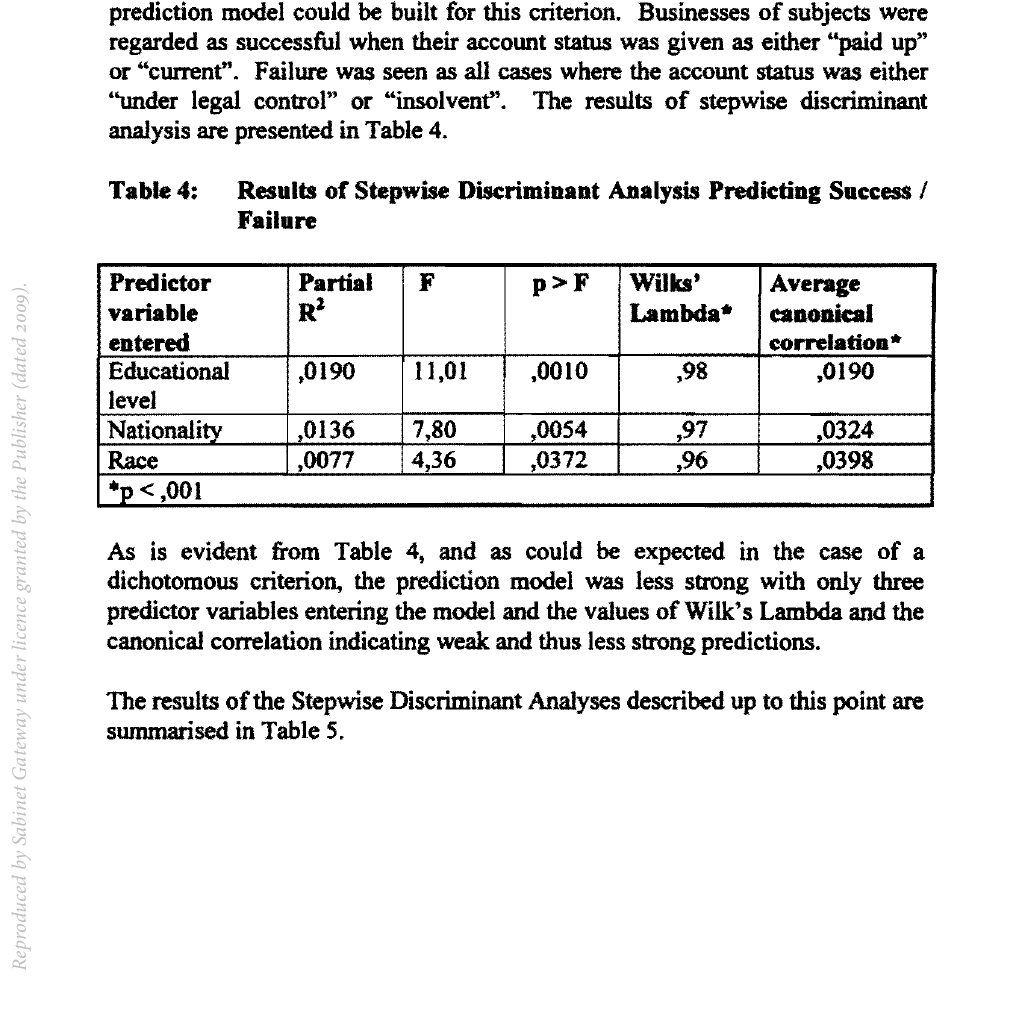
Results of Stepwise Discriminant Analysis Predicting Success